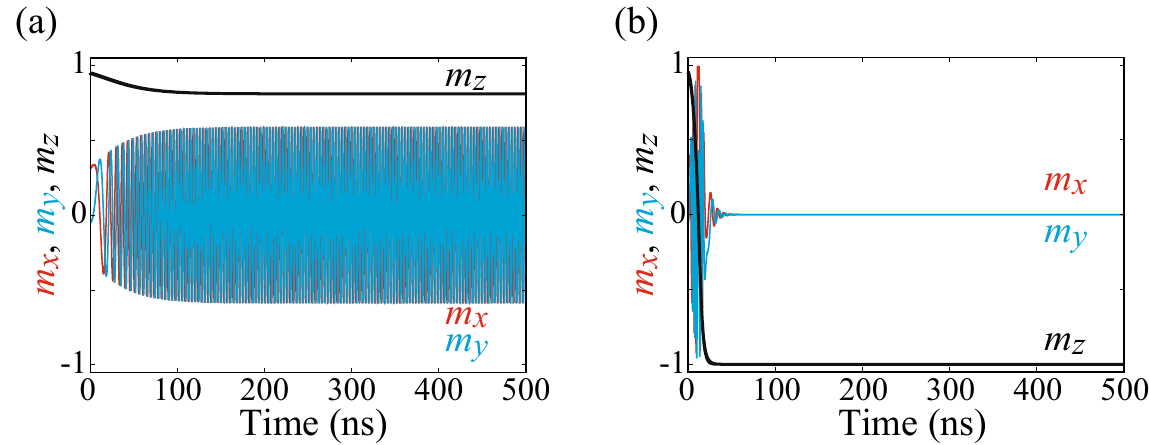
Figure 4. Examples of the time evolutions of m x (red), m y (blue), and m z (black) in the presence of spin-transfer torque, where the current density is ( a ) 0.06 MA/cm 2 and ( b ) 0.6 MA/cm 2